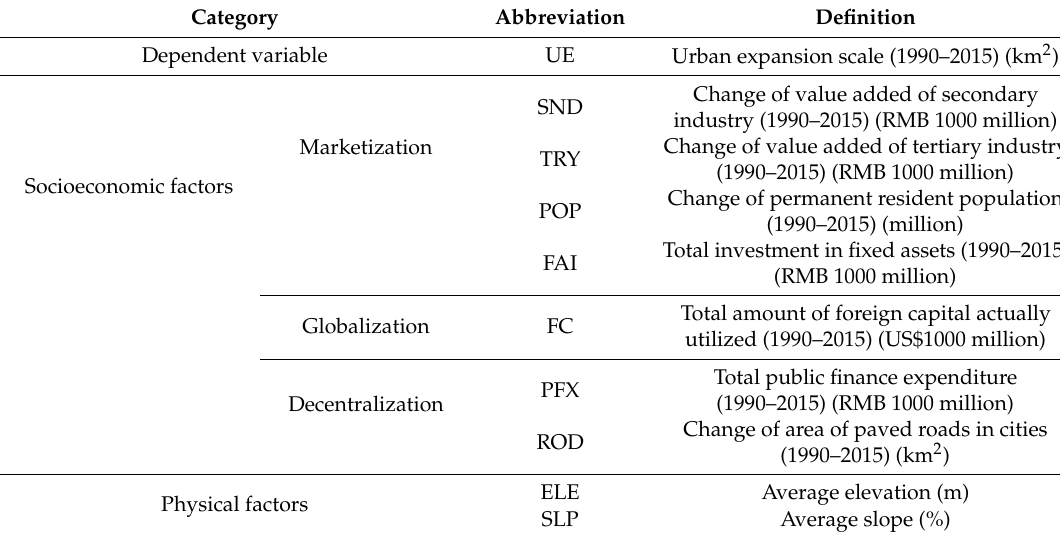
Table 1. Summary of